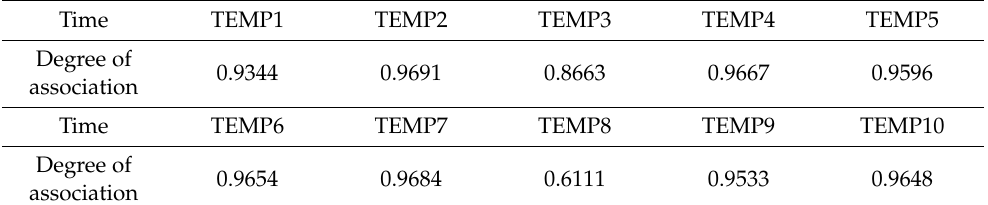
Table 3. Degree of gray correlation between the slope of the PE curve and the rate of